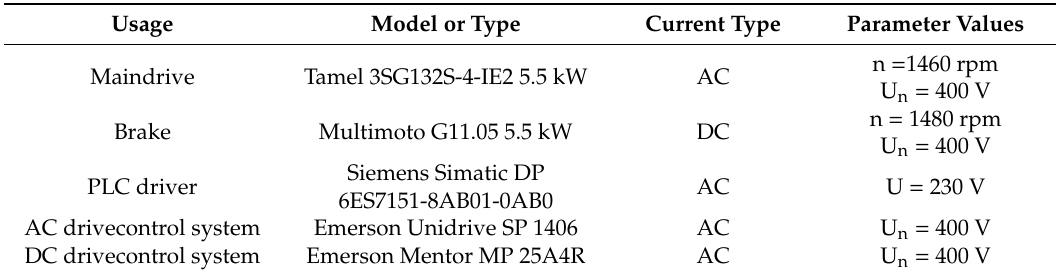
Table 4. The technical parameters of the test rig components.